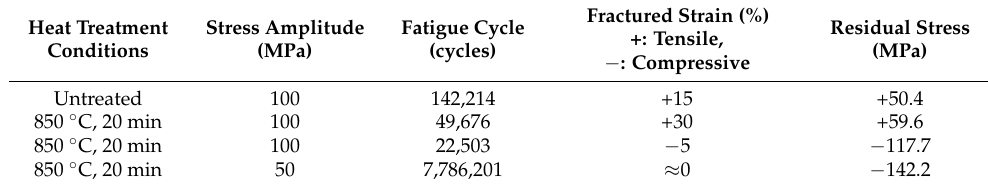
Table 6. Residual stress estimated after low cycle fatigue test using a micro-area X-ray residual stress measurement system.